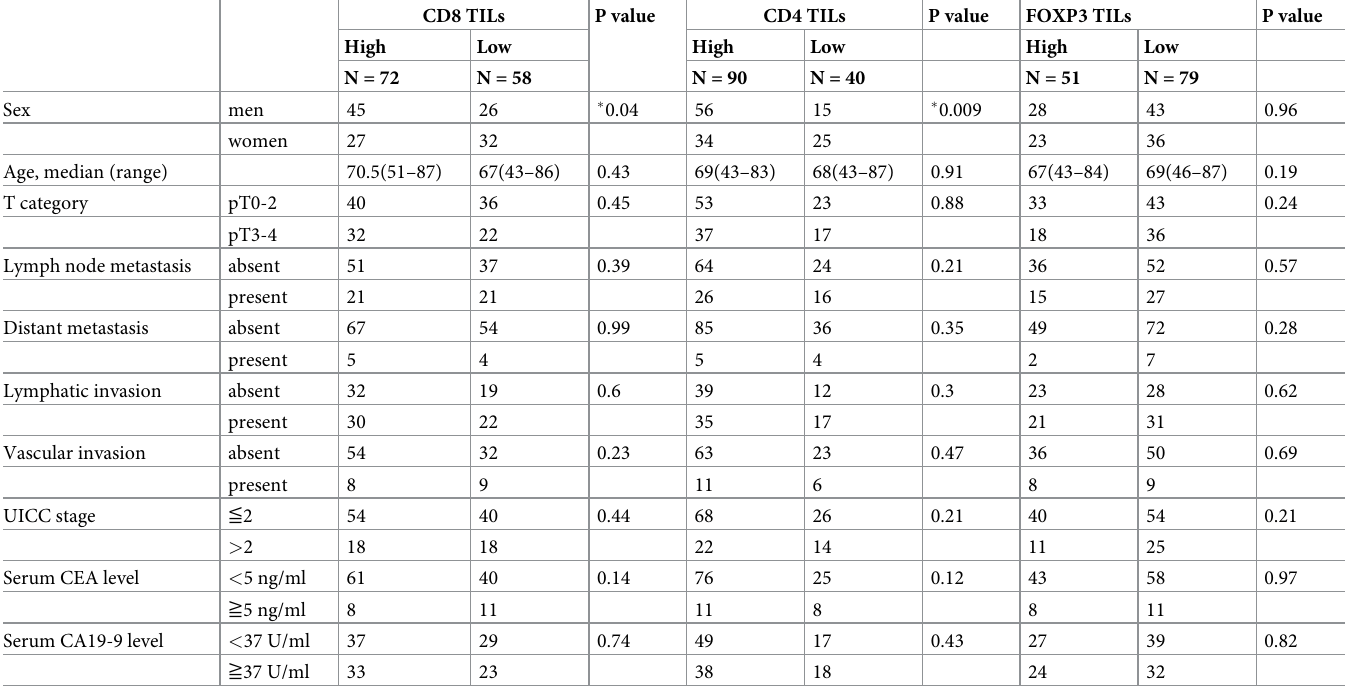
Table 2. Correlation between clinicopathological features and TILs in 130 patients with